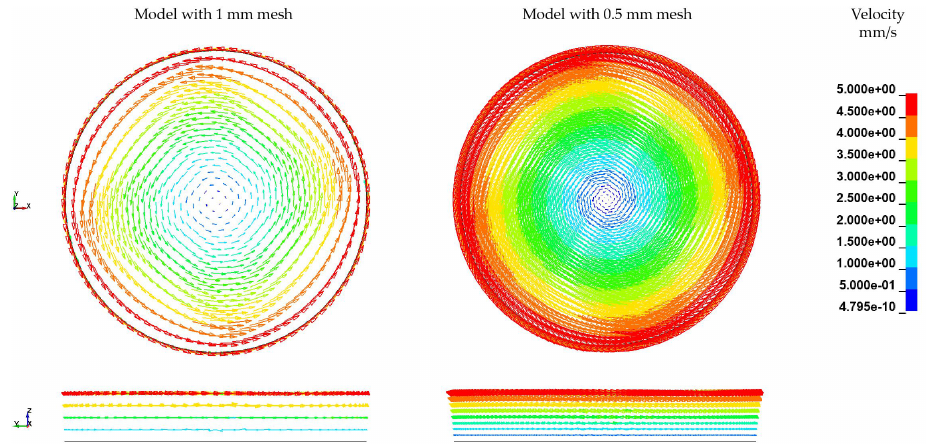
Figure 23. Comparison of velocity distribution by different mesh fineness.